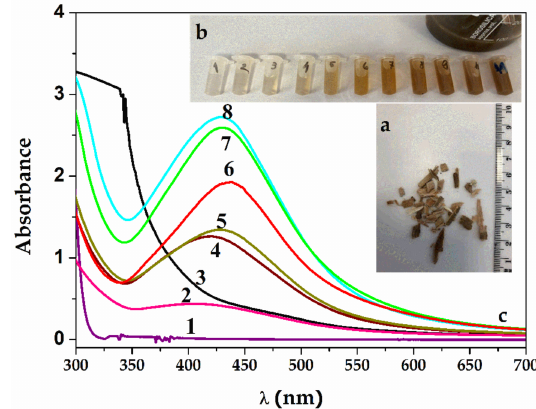
Figure 1. ( a ) Salix alba L. bark was collected in D â mbovi¸ta County, Romania, from willow trees. ( b ) Color change of the solution from yellow to dark brown. ( c ) UV–Vis spectra of SAgNP-WT samples obtained by reduction in time with willow aqueous extract: 1—AgNO 3 0.5 mM; 2—SAgNPs- WT 1S (after 5 min); 3—willow extract; 4—SAgNPs-WT 4S (after 10 min); 5—SAgNPs-WT